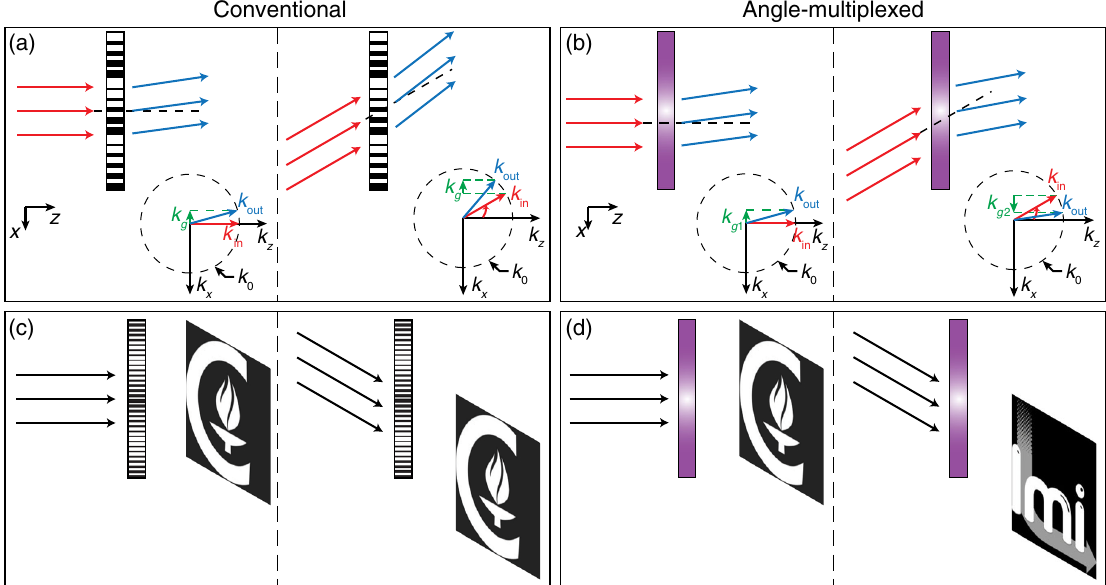
FIG. 1. Angle-multiplexed metasurface concept. (a) Schematic illustration of diffraction of light by a grating. A grating adds a fixed linear momentum ( ℏ k ) to the incident light, independent of the illumination angle. If the illumination angle deviates from the g designated incident angle, light is deflected to a different angle, which is dictated by the grating period. (b) Illustration of the angle- multiplexed metasurface platform. This platform provides different responses according to the illumination angle. For instance, two gratings with different deflection angles (different grating momenta) can be multiplexed such that different illumination angles acquire different momenta. (c) Illustration of a typical hologram that creates one specific image (Caltech logo) under one illumination angle (left). The same hologram will be translated laterally (and distorted) by tilting the illumination angle (right). (d) Schematic illustration of an angle-multiplexed hologram. Different images are created under different illumination angles. For ease of illustration, the devices are shown in transmission, while the actual fabricated devices are designed to operate in reflection